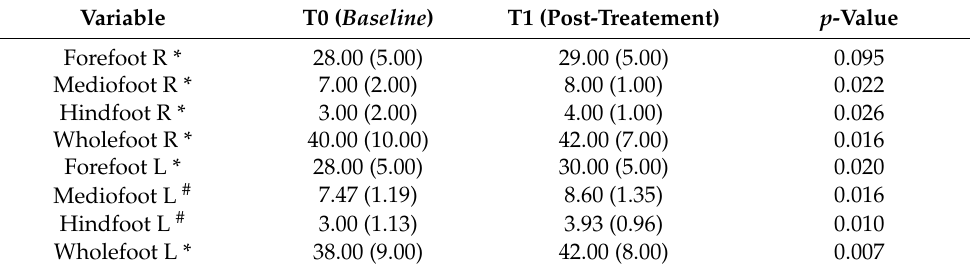
Table 3. Intragroup comparisons (T0 vs. T1) of the plantar tactile sensitivity for the conventional group of older women participating in the study. Jequi é , Bahia, 2022. Variable T0 ( Baseline )